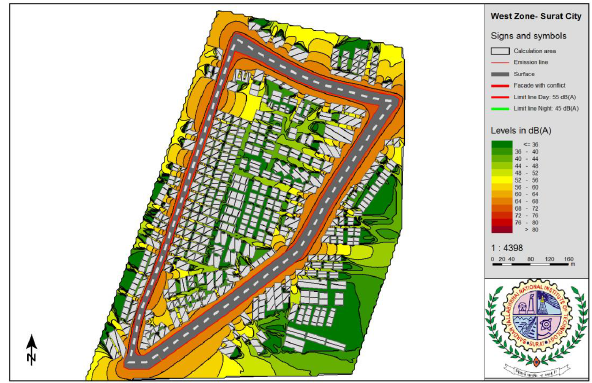
Figure 9: Day-time noise map of West zone using CORTN: 88